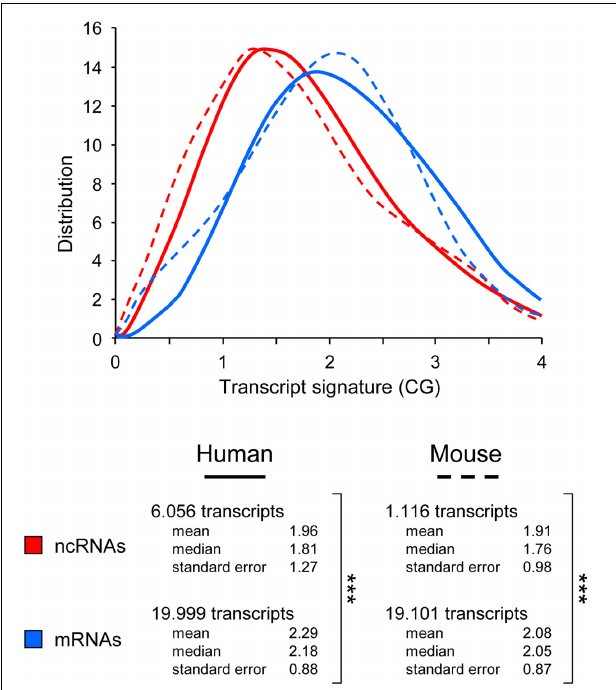
FIGURE 2 | Use of the CG dinucleotide frequency to categorize whole genome transcripts. Distribution of transcript signature scores (CG) obtained from ncRNA, mRNA and all grouped transcripts in human and murine sequences. Human and mouse transcripts in were downloaded from NCBI (human.rna.fna and mouse.rna.fna, respectively) and filtered to specifically select lncRNA and mRNA sequences. Briefly, lncRNAs were selected using NR_ as RefSeq accession number filter, and mRNAs were depleted using “partial,” “predicted,” “RIKEN,” “transcript variant” (with a number > 1 to only keep the first one) and “NR_” as keywords. Number of RNA sequences used for the distribution plots, including the mean, median, and standard error for each dataset. ∗∗∗ p -value < 0.005 (student’s t -test,